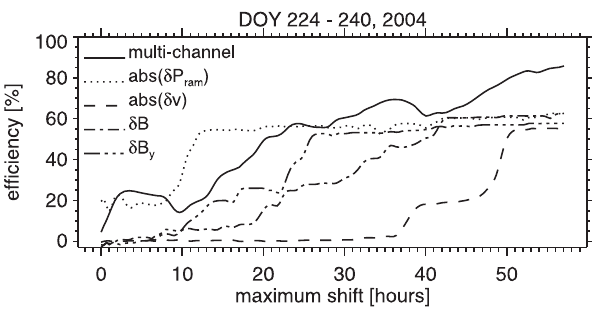
Fig. 7. Efficiency functions for the absolute time derivative of the ram pressure abs(δP ram ) using six different output signals: total SKR intensity integrated over the whole frequency range (solid line), mean intensity (dotted), intensity integrated from 300 − 1200kHz (short dashes), frequency bandwidth (dash-dot), up- per SKR frequency limit (dash-dot-dot-dot) and lower SKR fre- quency limit (long